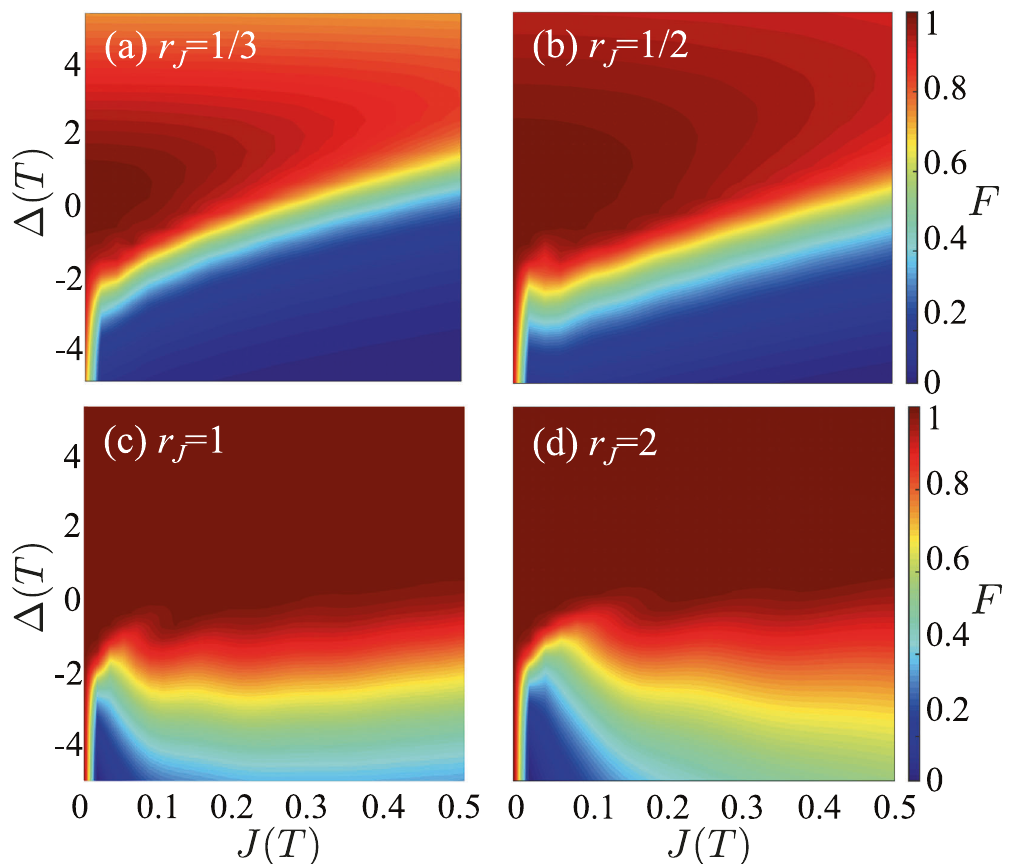
Fig. 4 Fidelity with MI initial state. a – d Fidelity of the prepared state F vs target hopping rate J ( T ) and target detuning Δ ( T ) for ramping index r J given in the panel. Here g ( t ) ≡ 1, J (0) = Δ (0) = 0, r Δ / r J = 1, and T = 15 π / g